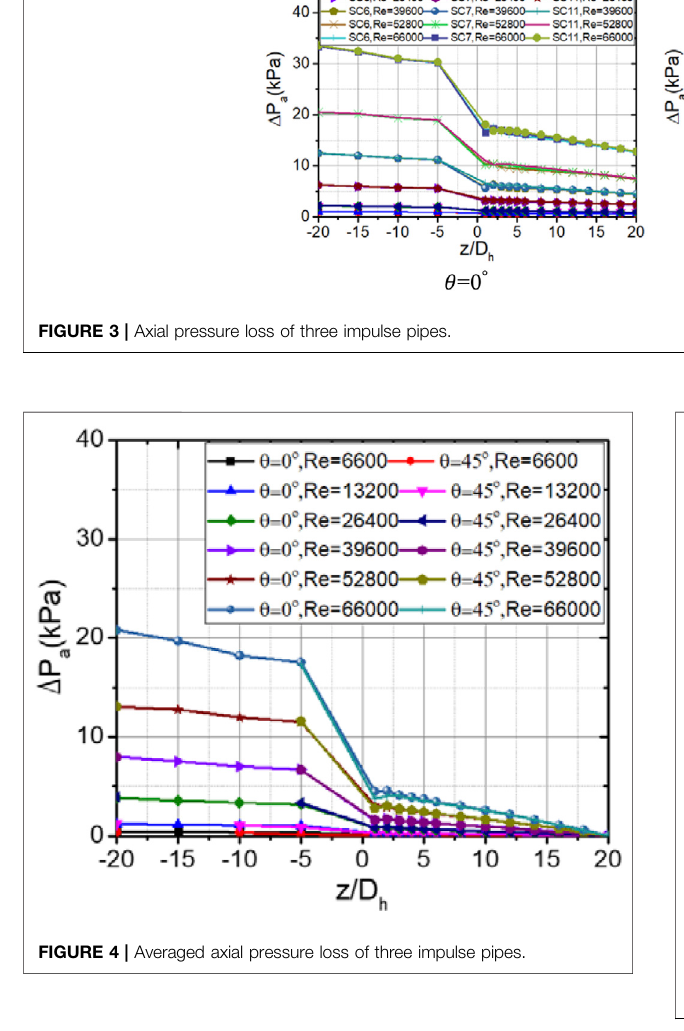
xed on the top of the central impulse pipe, as shown in Figure 2E . We de fi ne the orienting angle on the x axis as equal to 0 ° and that on the y axis as equal to 90 ° . Combined